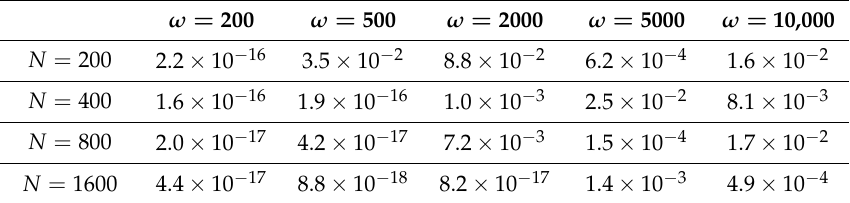
Table 2. Absolute errors of CCQ for Example